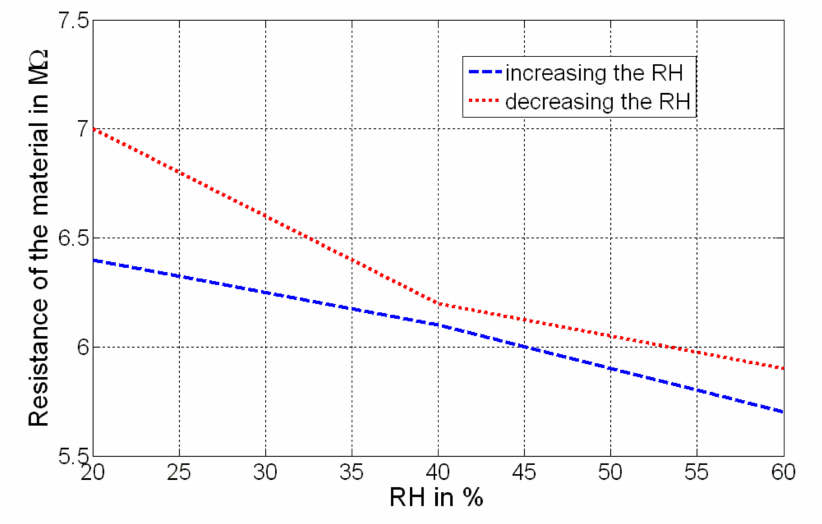
Figure 11. Resistance of the material, considering the increasing and the decreasing condition of